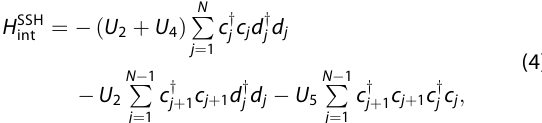
(cid:5) , schematically shown in Fig. 3b. As before, the superscripts indicate the edge localization (left/right) of the 2 fermions, while the subscripts indicate the occupied sublat- tices; we remind the reader that the chain starts with an A-site on the left.